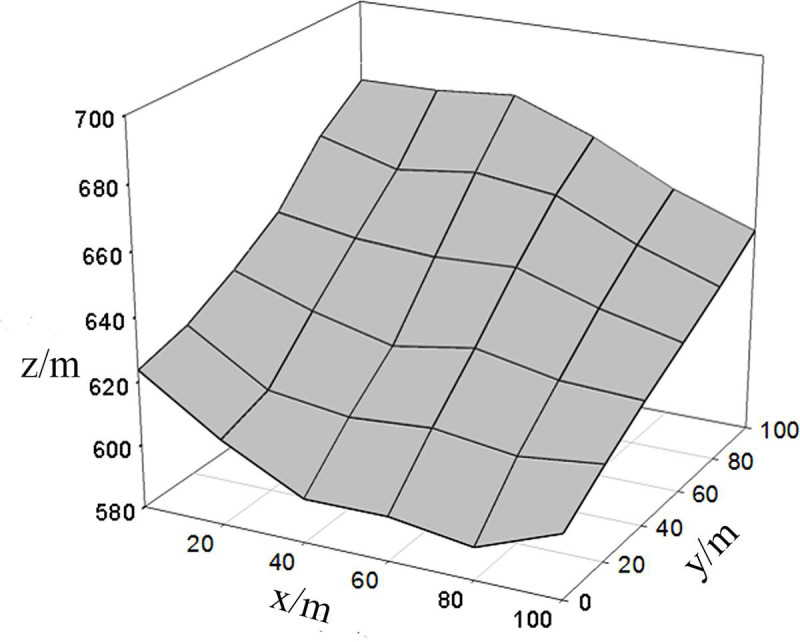
3D terrain map of the representative plot (100 m × 100 m) for the
evergreen broad-leaved forest.